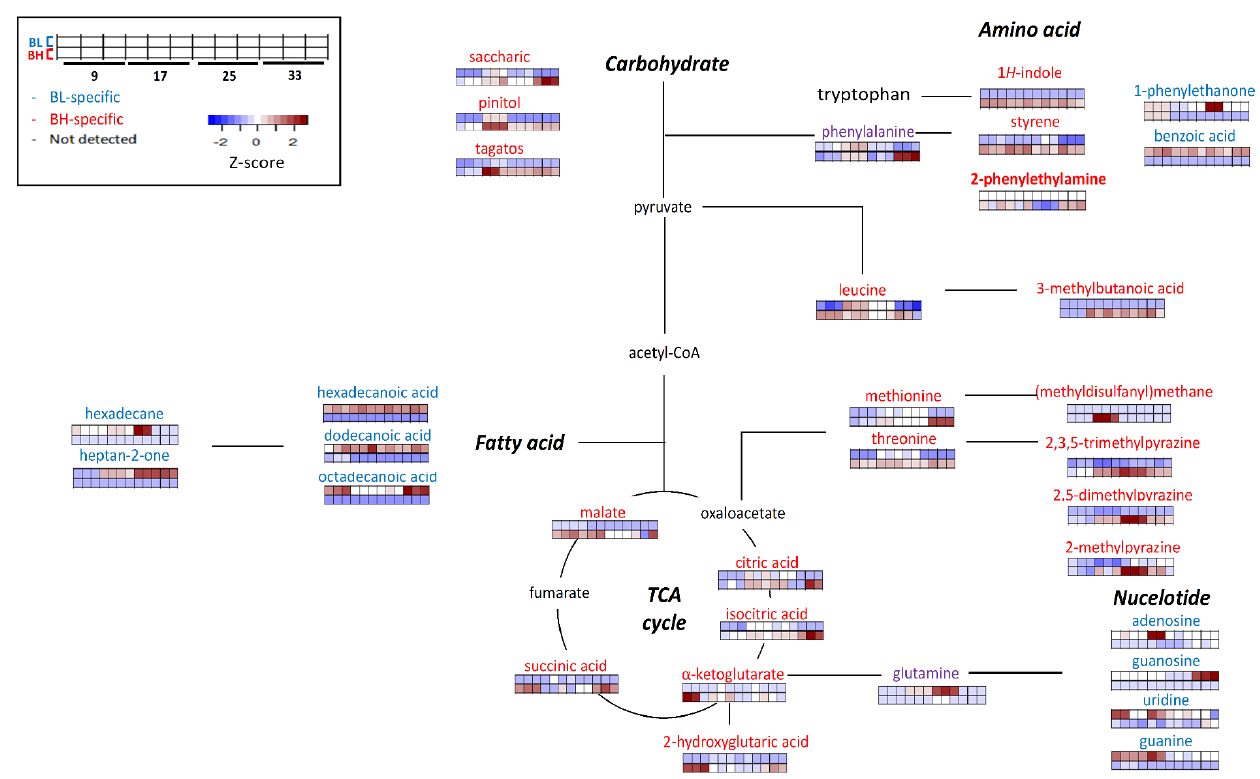
Figure 4. The possible metabolic pathway representing distinctive BH or BL-specificity. Metabolites labeled with red color shows BH-specific metabolites, while blue color represents BL-specific metabolites. The heatmap shows the z-score value of each metabolite, and color intensity represents the magnitude of variations: Red, up-expression; Blue, down-expression.